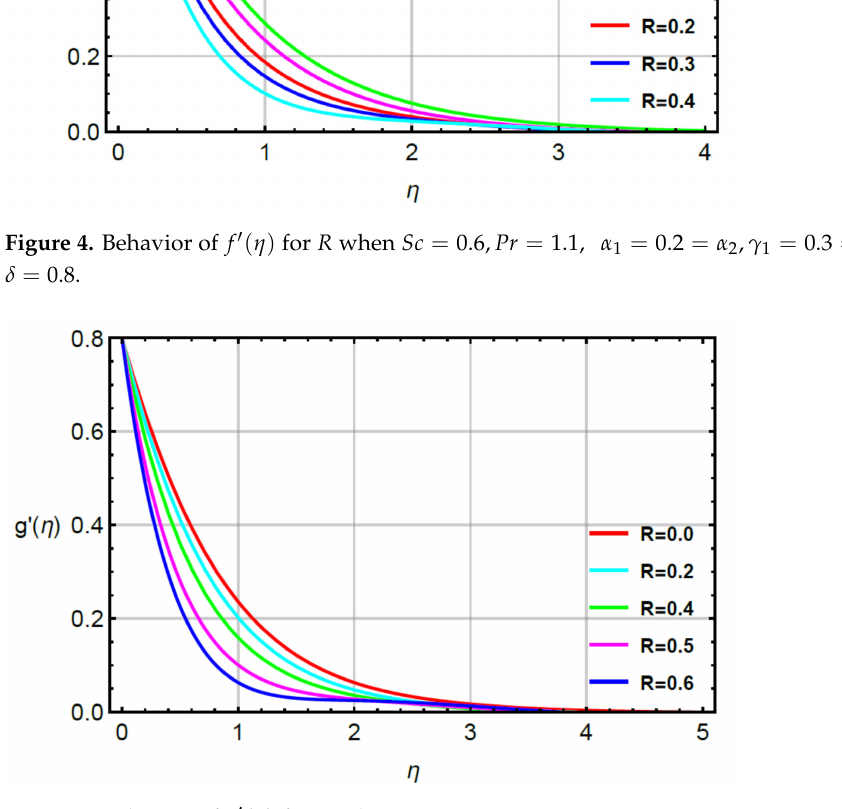
Figure 5. Behavior of g (cid:48) ( η ) for R when Sc = 0.6, Pr = 1.1, α 1 = 0.2 = α 2 , γ 1 = 0.3 = γ 2 , M = 0.1, δ = 0.8.